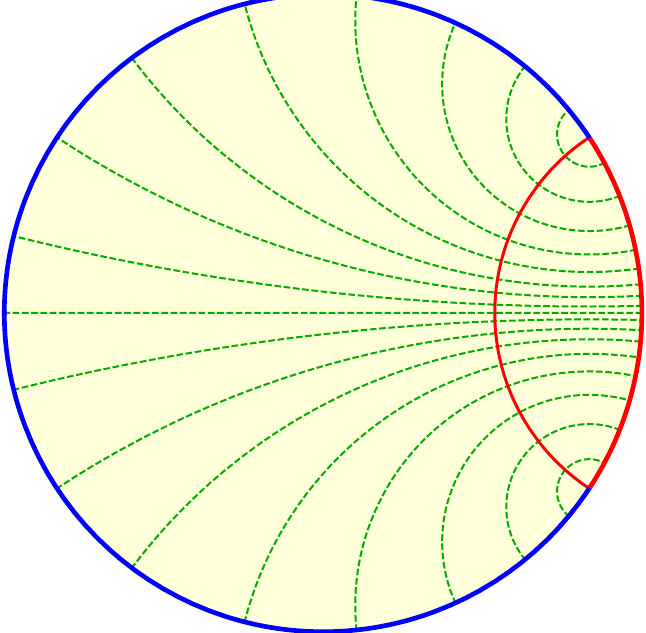
Figure 15 . Geodesic bit threads (green dashed circular arcs) in a fixed time slice of global AdS 3 (yellow unit disk, see (B.1)) for an arc of the boundary circle (red arc), whose RT curve is the red solid arc anchored to its